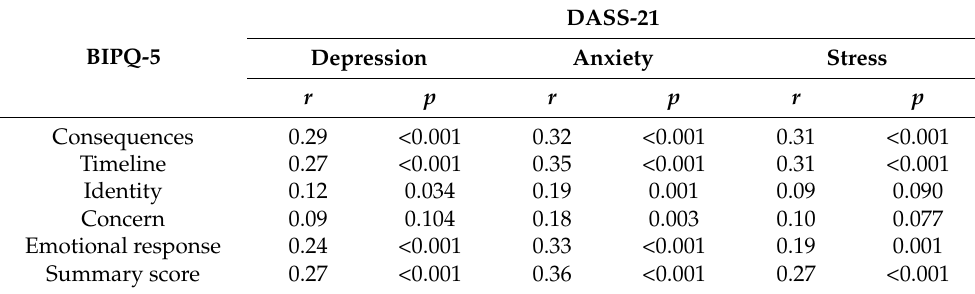
Table 3. Correlations between BIPQ-5 items and DASS-21 items.